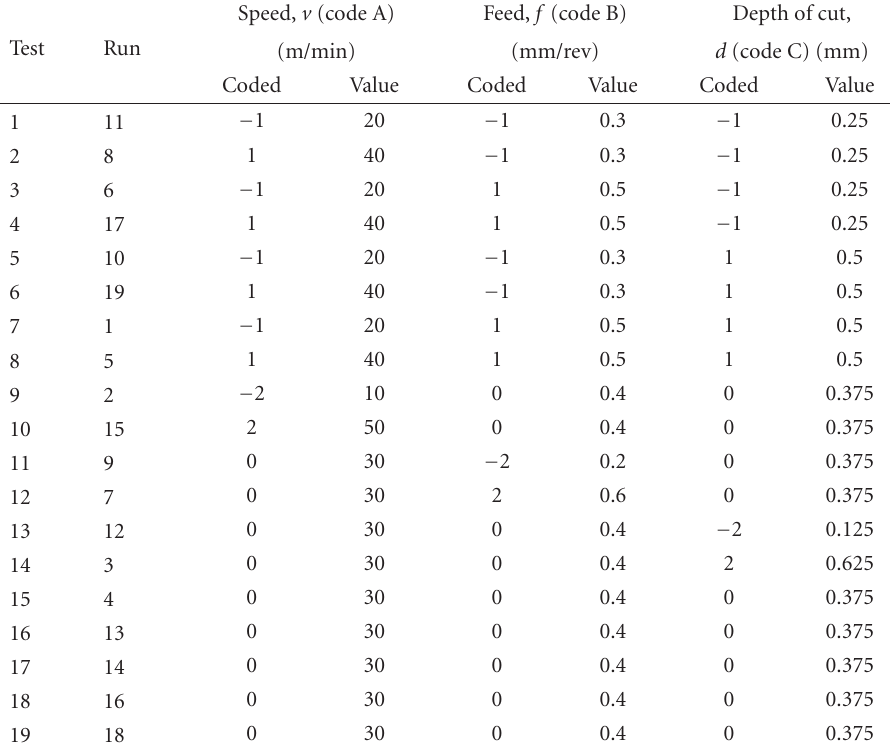
Table 4 . 1 . Experimental design matrix